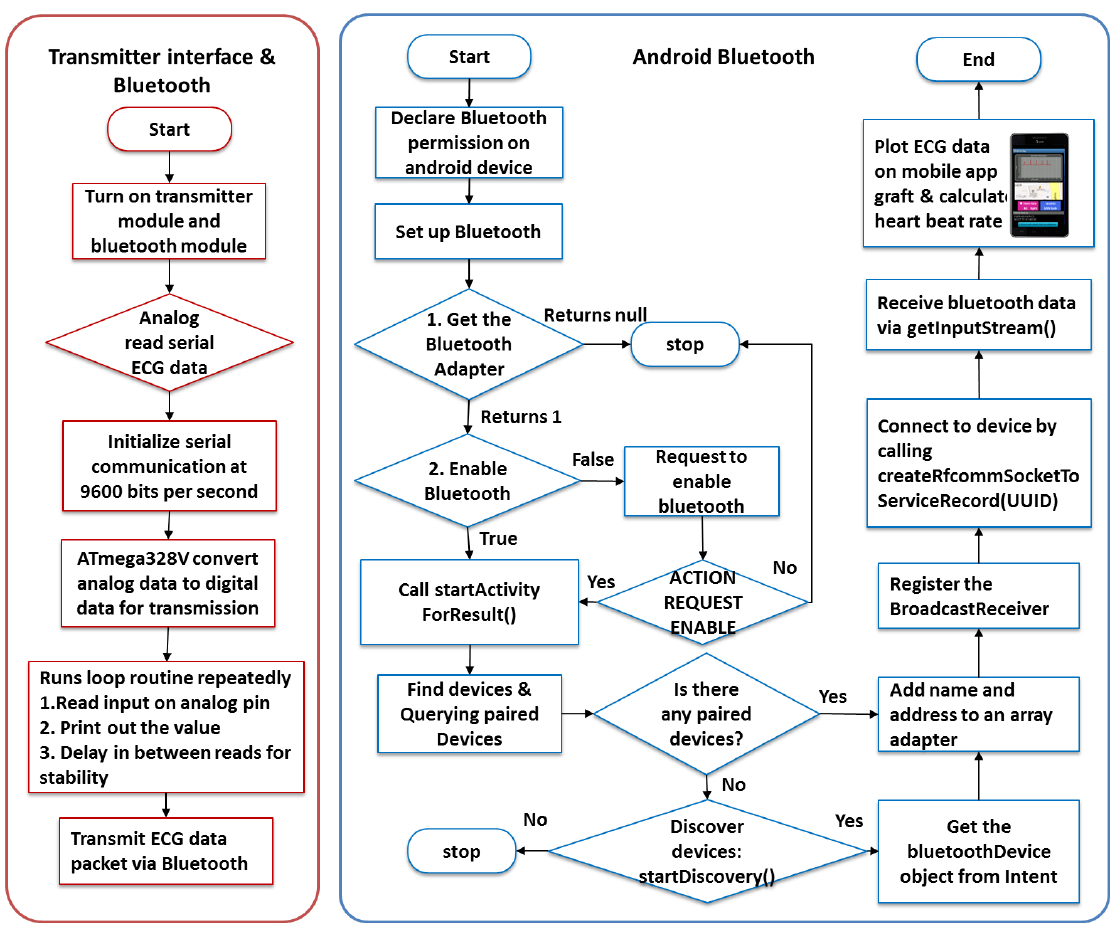
Figure 5. Bluetooth communication between the transmitter and mobile